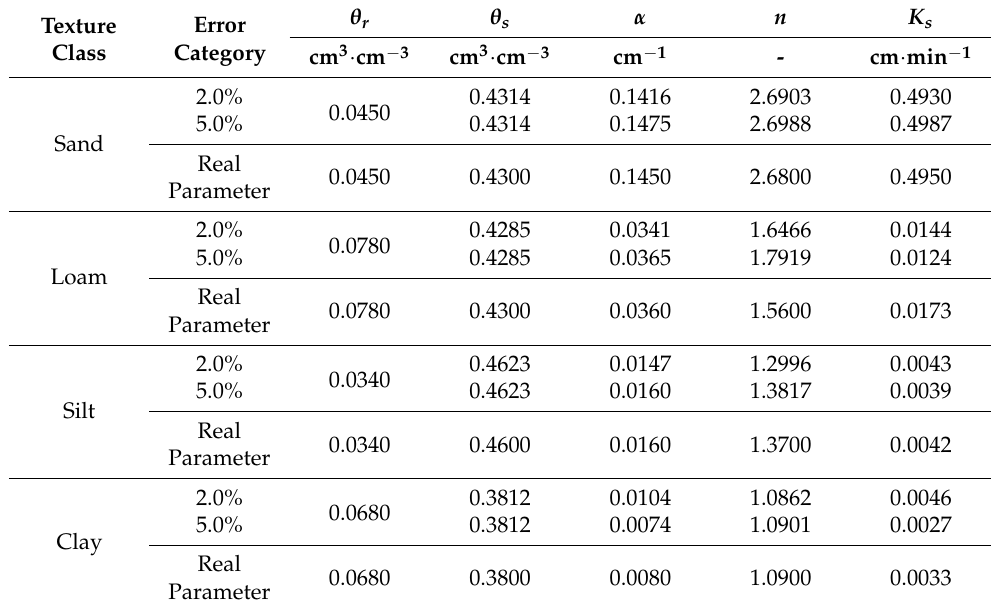
Table 7. Inverted parameters with random errors in cumulative infiltration for the four typical soils.